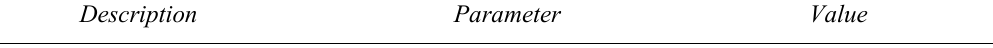
Table 4. Parameters of the model